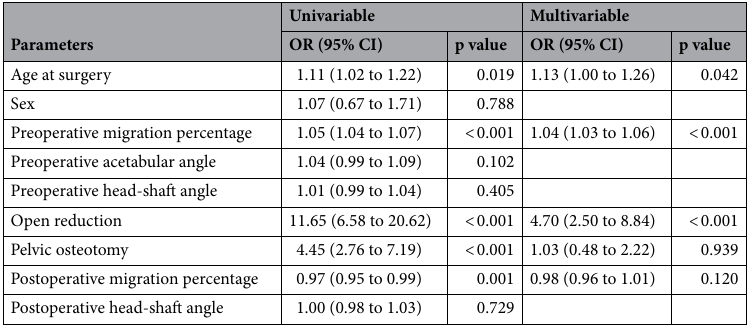
Table 5. Parameters associated with development of avascular necrosis of the femoral head. Generalized estimating equations were used to calculate the ORs and CIs; OR odds ratio, CI confidence interval.